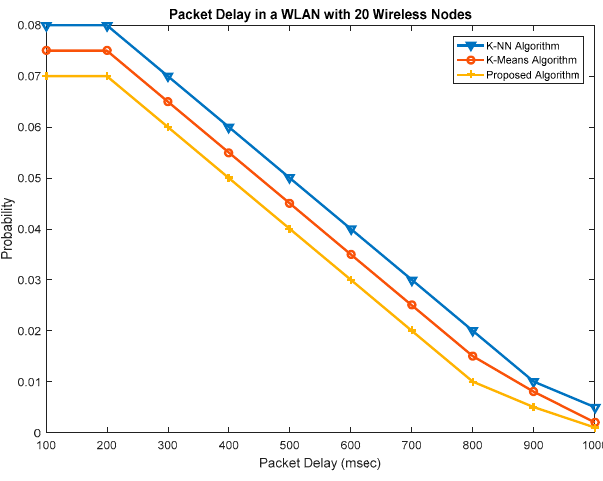
Figure 9. Probability versus of packet delay.